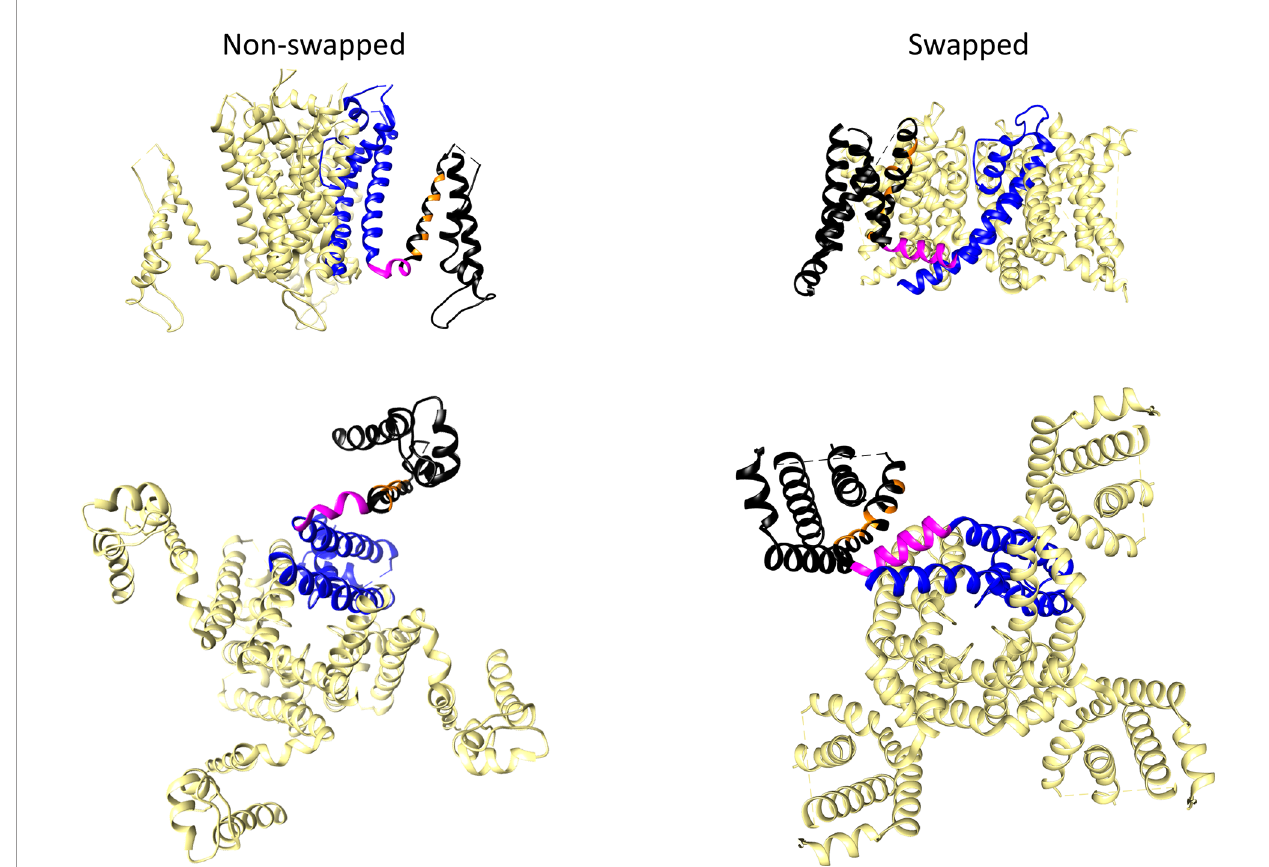
FIGURE 3 | Comparison of non-domain-swapped and domain-swapped architectures of Kv channels. Left, erg1 (Kv11.1/hERG, PDB: 5VA2) non-domain swapped structure. Right, Kv1.2 (PDB: 2A79) domain-swapped structure. Only the transmembrane core domains are depicted viewed from the membrane plane (top) and from the cytoplasmic side (bottom). One of the subunits is shown coloured with the pore domain (PD) structures in blue, the S4 – S5 linker in magenta, and the voltage sensing domain (VSD) in black. Orange is used to mark the position of positively charged residues in the S4 transmembrane helix of the